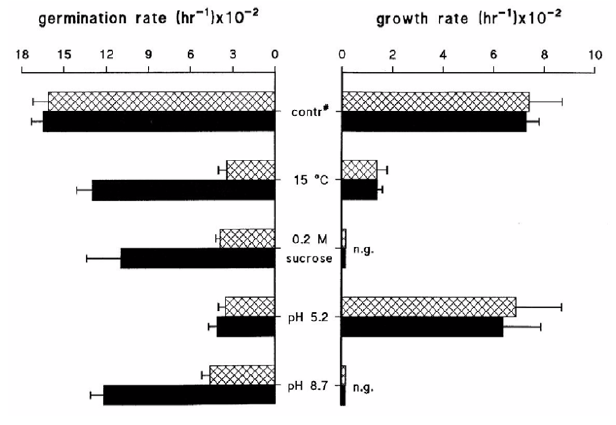
Figure 2 The effect of stress on growth and spore germina- tion. Plc -null (filled bars) and wild-type control (hatched bars) spores (left panel) or amoebae (right panel) were inoculated in medium at different conditions as indicated. Germination and growth rate were measured, repectively, which are the first order rate constants for germination and growth, respectively. The results shown are the average and standard deviations for three experiments. The control # refers to medium at pH 7.1 incubated at 22 ° C; n.g., no growth was observed, the bars indicate the maximal growth